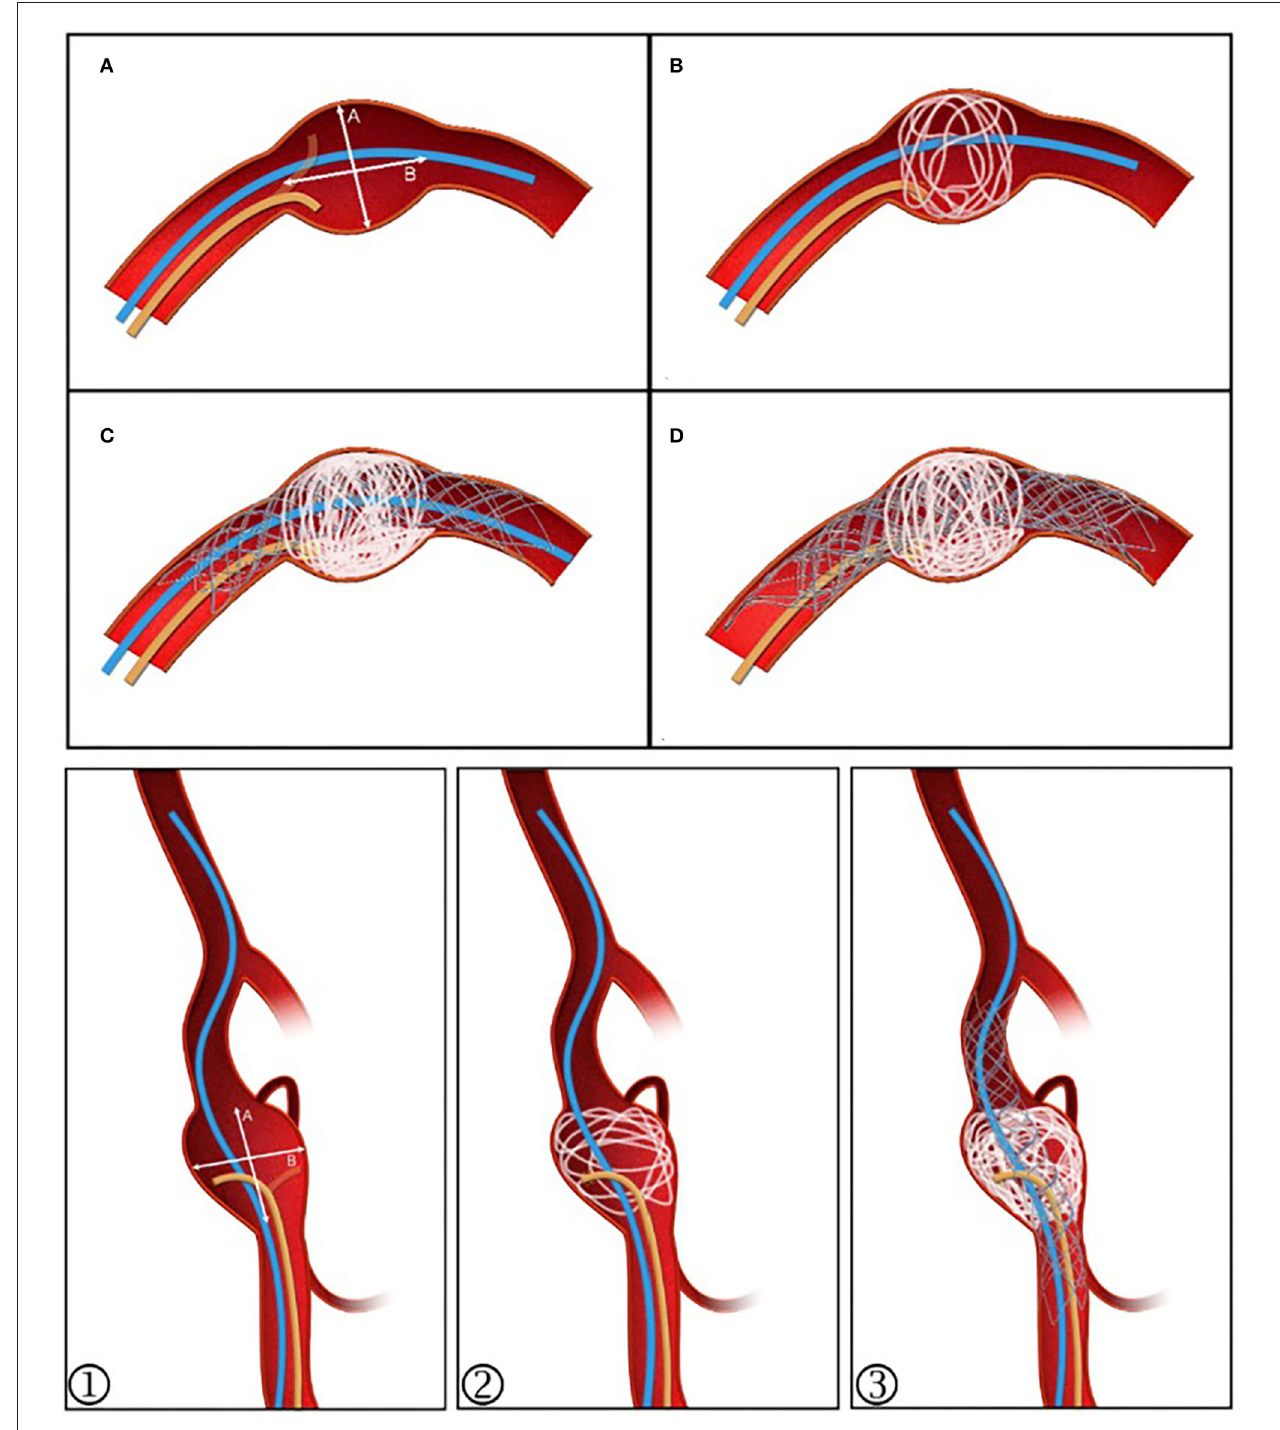
FIGURE 1 | Post-large coil stenting technique schematic diagram. (A) The stenting microcatheter (blue) and unshaped coiling microcatheter (yellow) are positioned. (B) Coil diameter is selected with reference to the value ≥ A. The aneurysm sac is evenly filled. (C) Continued embolization using 2–4 coils, then deploying the stent and placing the stenting microcatheter at the distal segment as a backup. (D) If the sac is not densely embolized or coil protrusion into the stent occurs, a second stent can be released to provide flow diversion, allowing further embolization to proceed. ‹ – fi For those with branches or an irregular sac, the stent can be semi-released to assist in forming a basket while protecting the